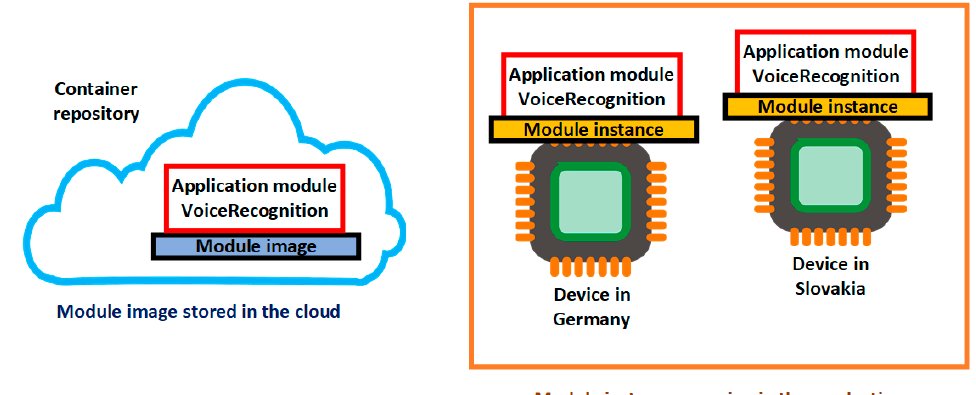
Figure 5. Module’s image and instances.